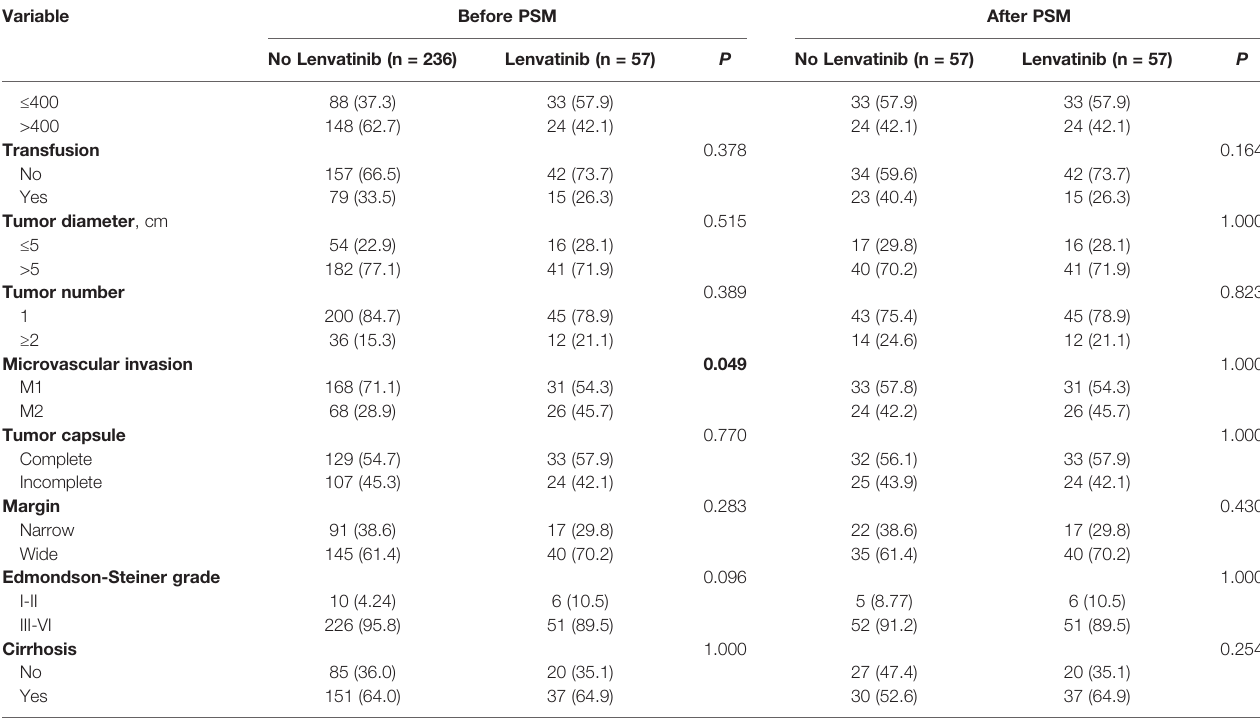
Comparison of the clinical data of the two groups is shown in Table 1 . Statistical differences were observed in HBV-DNA, PT, AFP and MVI. In order to eliminate potential bias induced by differences in baselines characteristics, PSM was implemented both included 57 patients after PSM ( Table 1 ).